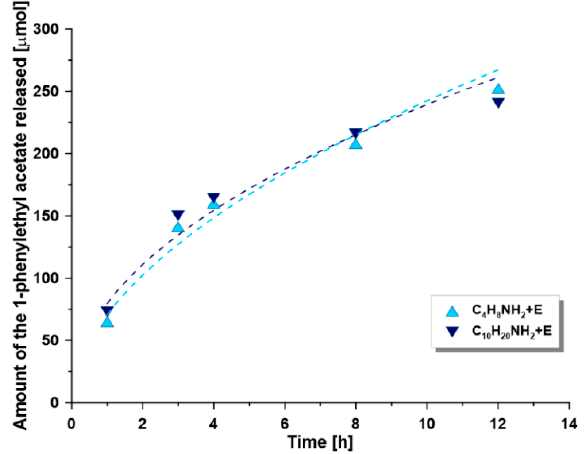
Figure 7. Amount of the 1-phenylethyl acetate produced vs. time for different CALB-immobilized membranes. ( R,S )-1-phenylethanol 5 mM, 2-fold excess of vinyl acetate, n -hexane as a medium, temperature 30 ◦